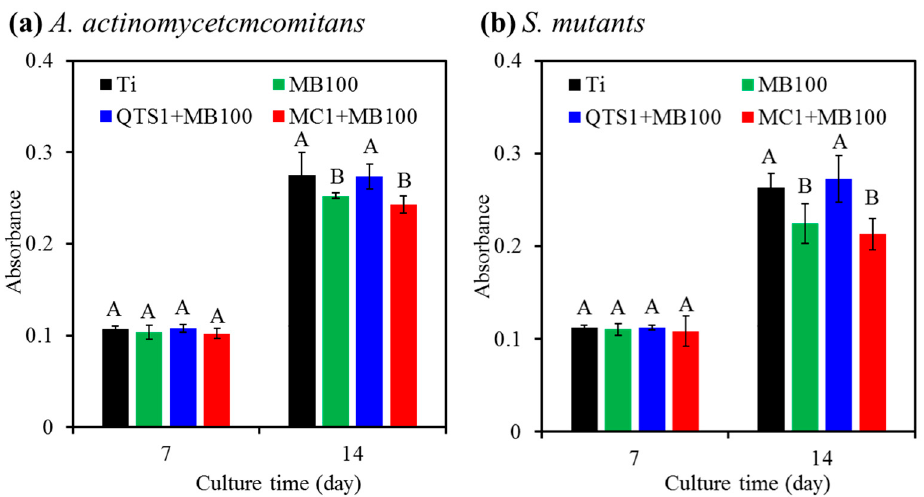
Figure 11. Mineralization analysis of MG63 cells cultured on the surfaces after PACT (MB100, QTS1 + MB100 and MC1 + MB100) treated samples contaminated with ( a ) A. actinomycetcmcomitans and ( b ) S. mutants . The sterile Ti alloy was used as a control. Different capital letters showed statistically significant differences at p < 0.05 ( n = 5).